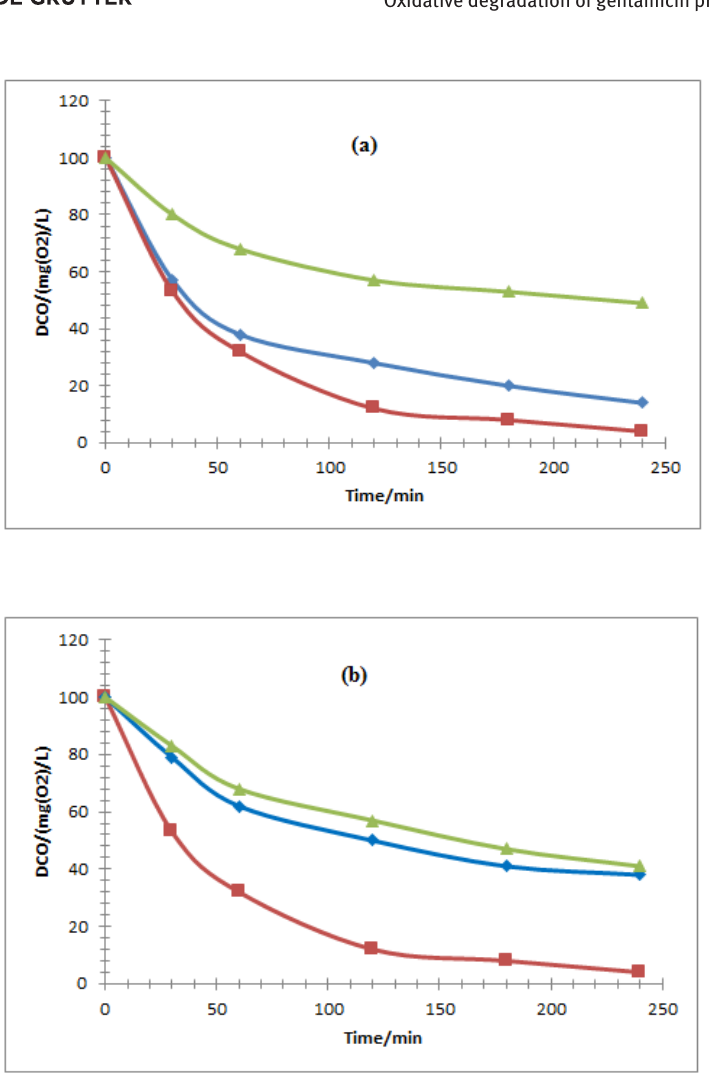
Figure 2: Effect of (a) applied current and (b) catalyst concentration on gentamicin concentration decay during electro-Fenton process of solution COD at pH 3 in 0.05 M Na 2 SO 4 solution. [Fe 2+ ] = 0.1 mM. (a) Applied current I (mA /cm 2 ) : 60 ( ), 100 ( ). (b): [Fe 2+ ] (mM) = 0.1 (